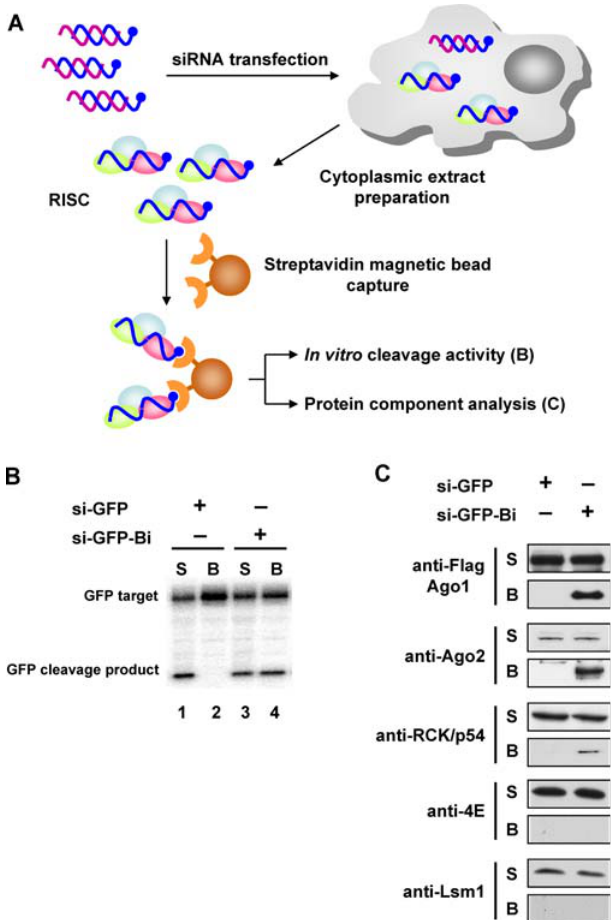
Figure 2. Isolation of Active Human RISC Containing RCK/p54-Ago1/ Ago2 (A) Experimental outline to purify active human RISC. The guide strands of siRNA complexes targeting GFP (si-GFP) were conjugated with 3 9 biotin (si-GFP-Bi; blue strands) and transfected into HeLa cells. RISCs were captured by incubating cell extracts with streptavidin-magnetic beads. (B) Target mRNA is cleaved by biotin-captured RISC. Bead (B) and supernatant (S) phases of captured RISC were incubated with 124-nt 32 P- cap-labeled GFP target mRNA. The reactions were stopped after 120 min, and products were resolved on 6% denaturing polyacrylamide gels. (C) Biotin-captured RISC contains proteins associated with mRNA processing. Active human RISC from HeLa cells expressing Flag-Ago1 was captured by biotin-siRNA and its protein composition was analyzed by immunoblot using anti-Flag, anti-Ago2, anti-RCK/p54, anti-Lsm1, and anti-eIF4E antibodies. DOI: